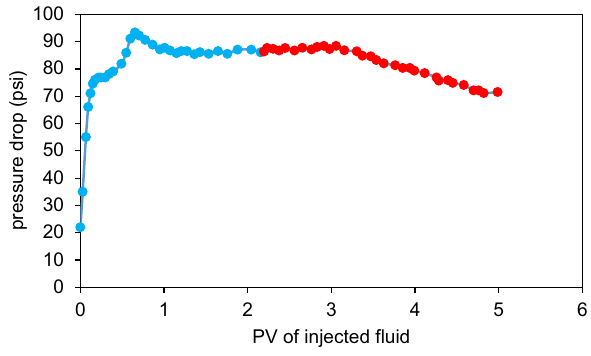
Fig. 14 Pressure drop diagram in the process of saline water and TR-880 solution flooding at 1000 ppm concentration of formation saline water base at 351.15